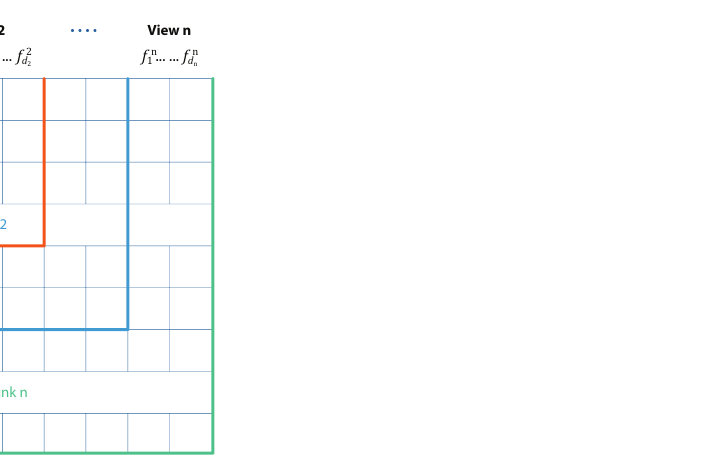
Figure 4. Illustration of proposed dynamic view structure where instances are rows and features are columns. Each new chunk consists of new instances and an additional view.